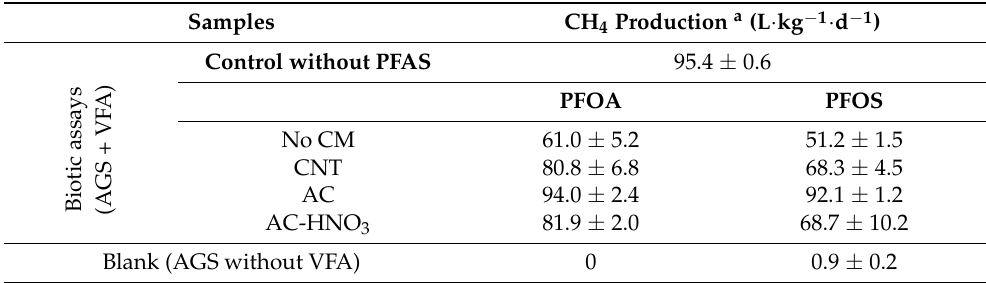
Table 2. Methane production rate from the anaerobic degradation of VFA, in the presence